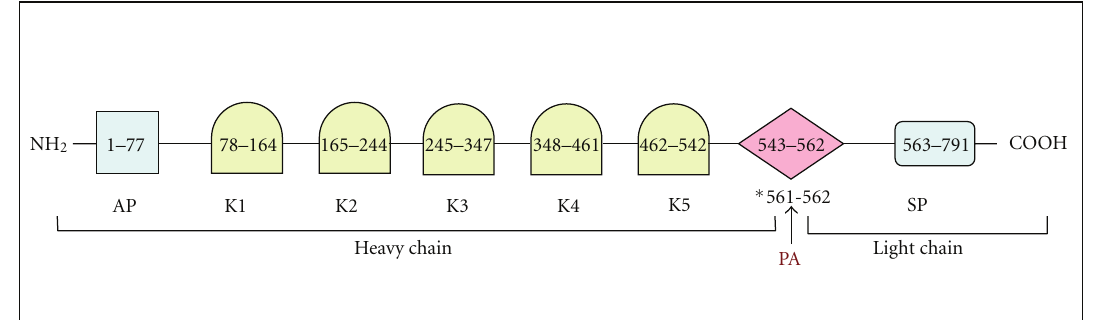
Figure 2: Schematic presentation of the structure of human Plg. From the amino terminus of the mature protein, the 77-residue activation peptide (AP) is followed by 5 kringle domains (K1–K5) containing lysine binding sites and the catalytic SP domain. R561-V562, which is proteolytically cleaved to generate Pm, is shown with an asterisk. The cleavage site for plasminogen activator (PA) is shown by an arrow. Heavy chain and light chains after proteolytic cleavage are marked with